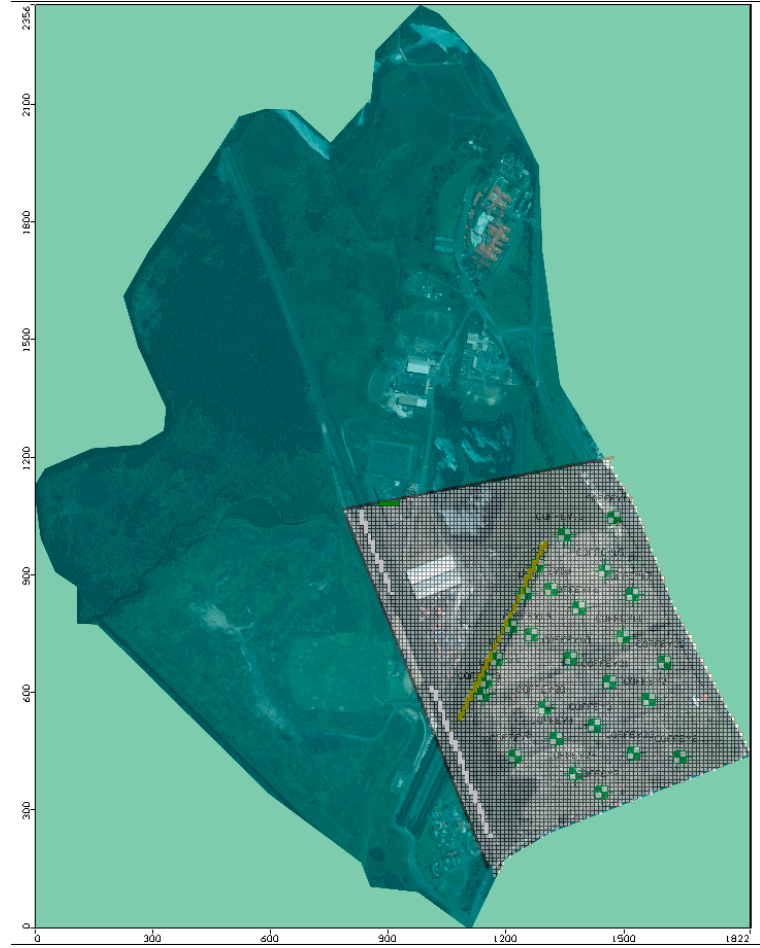
Figure 6. Groundwater Flow Model Grid. Embankment and railway lines represented as wall and drain packages respectively. The green cells represent General Head Boundary (GHB) in the northern part of the model. Bores are shown as green symbols.